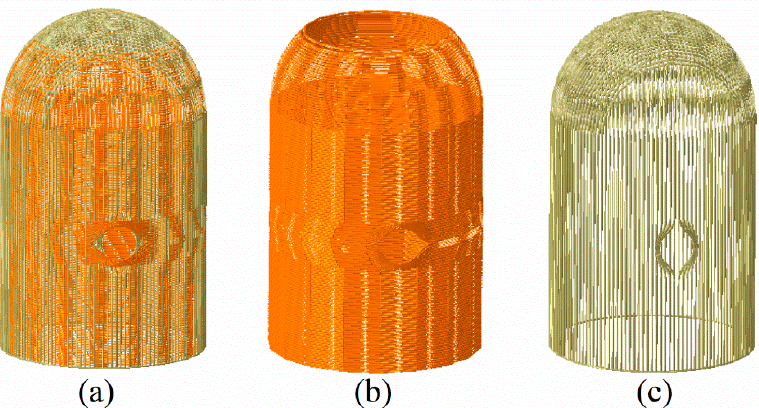
Figure 2. Highlighting tendon layout: ( a ) total of tendons, ( b ) hoop, ( c ) inverted “U” tendons.